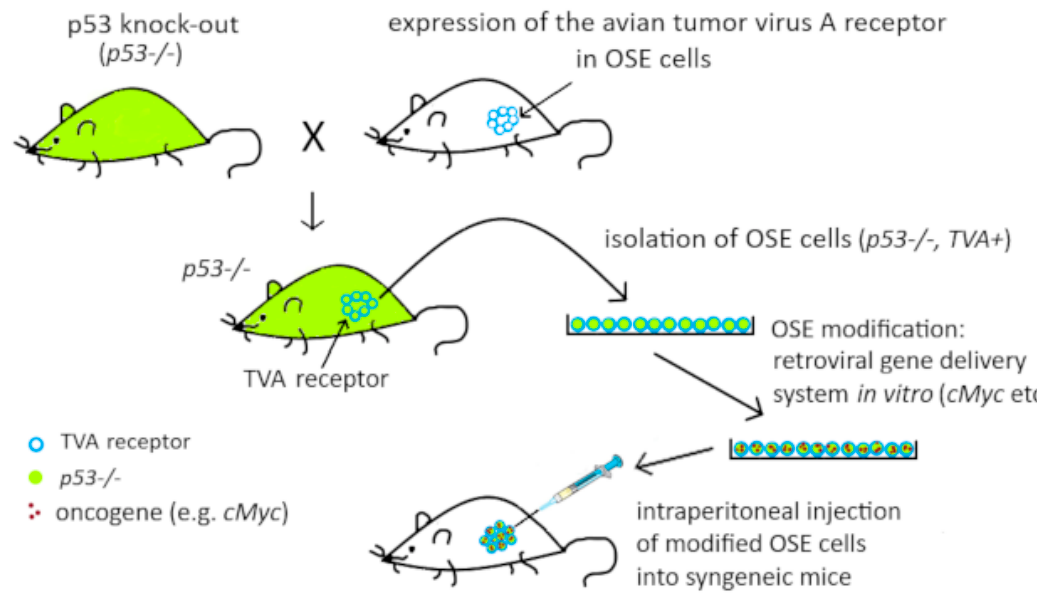
Figure 2. Mouse model designed by Orsulic et al. [67] to evaluate oncogenes necessary for neoplastic transformation of ovarian surface epithelium (OSE) cells with an inactive p53 gene. TVA, tumor virus receptor A.